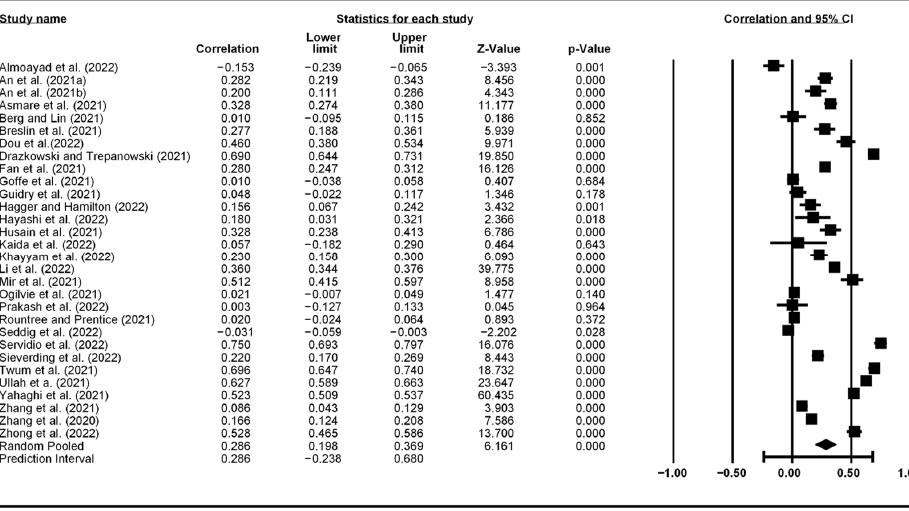
Figure 4. Forest plot showing perceived behavioral control and vaccination intention correlation.